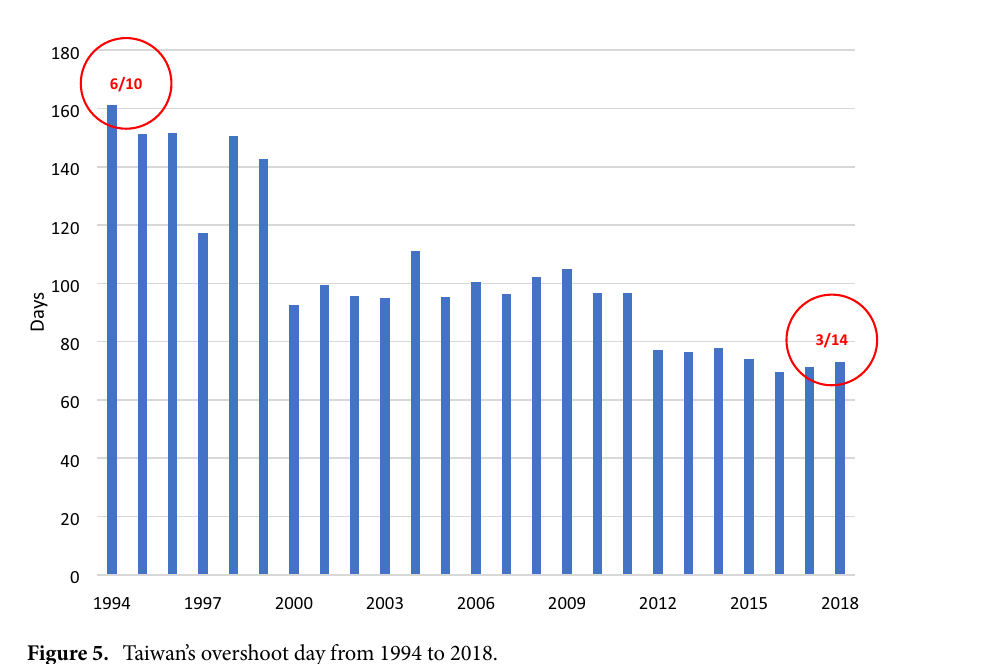
Figure 5. Taiwan’s overshoot day from 1994 to